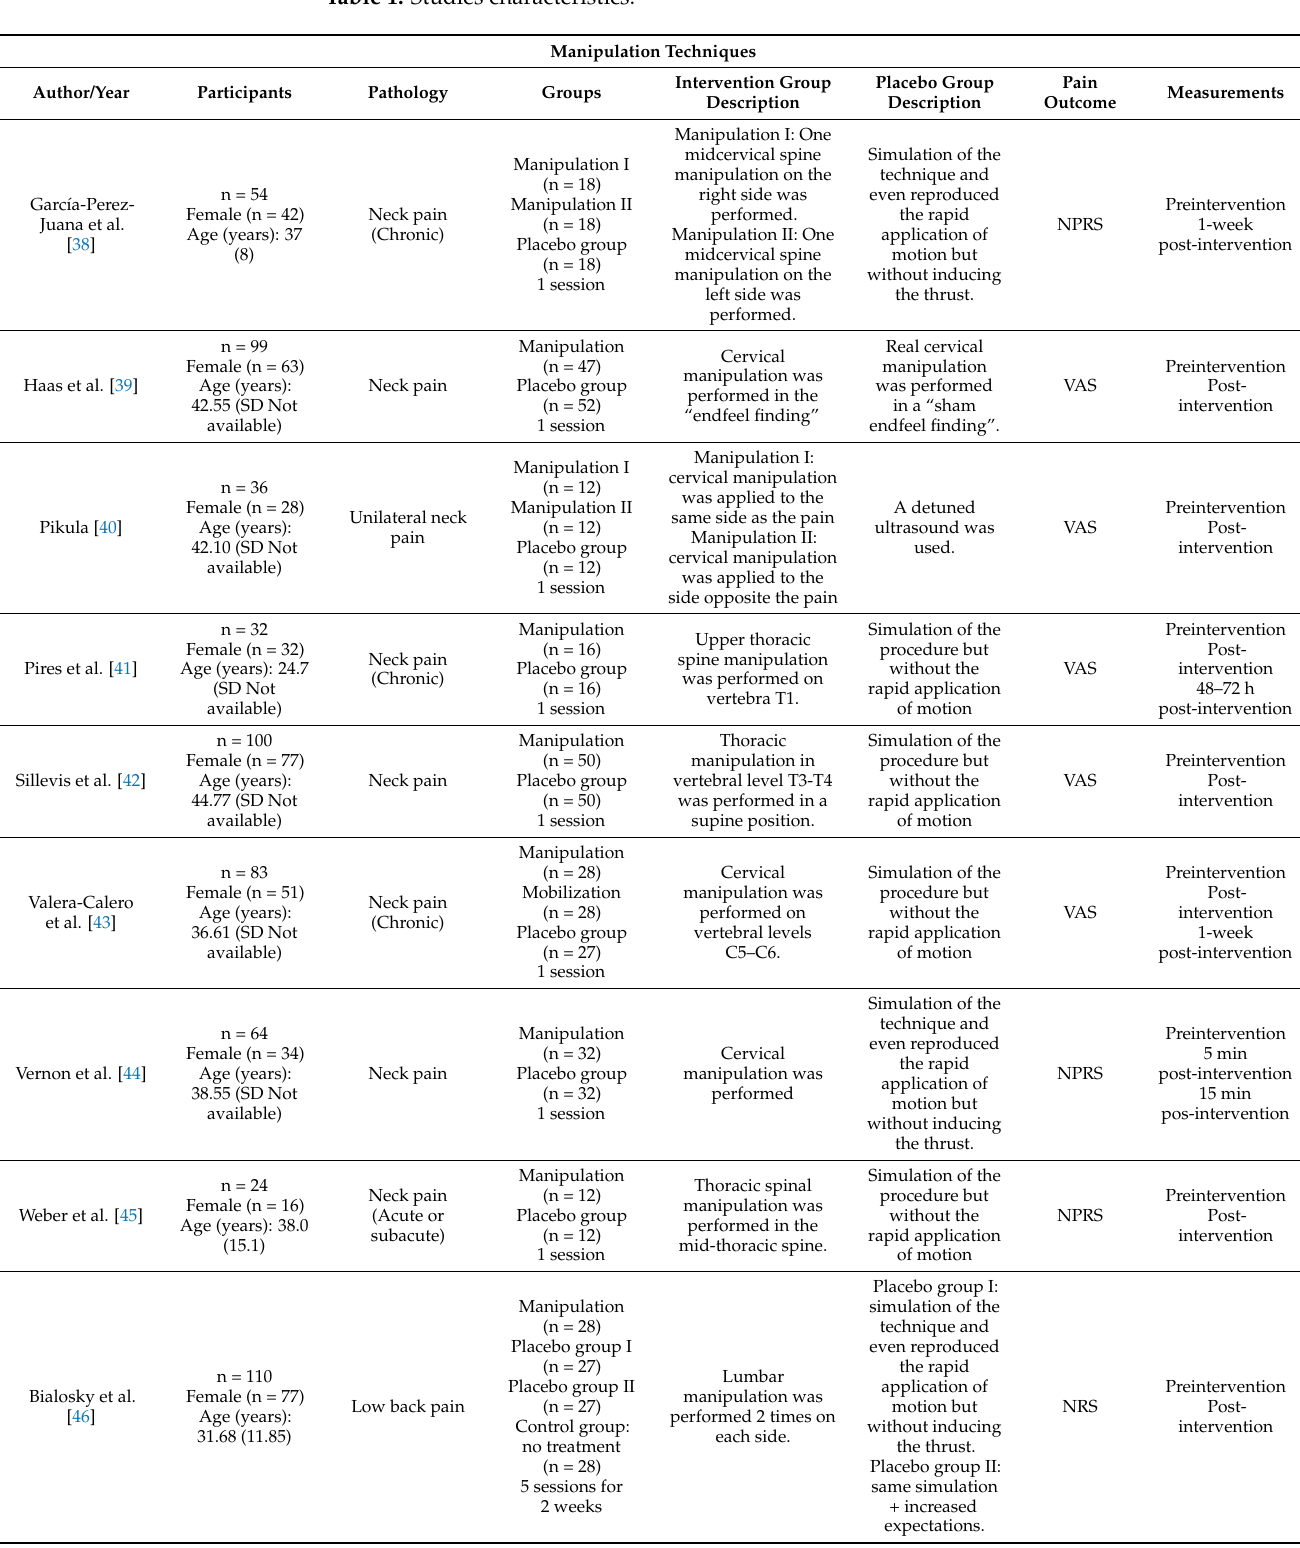
Table 1. Studies